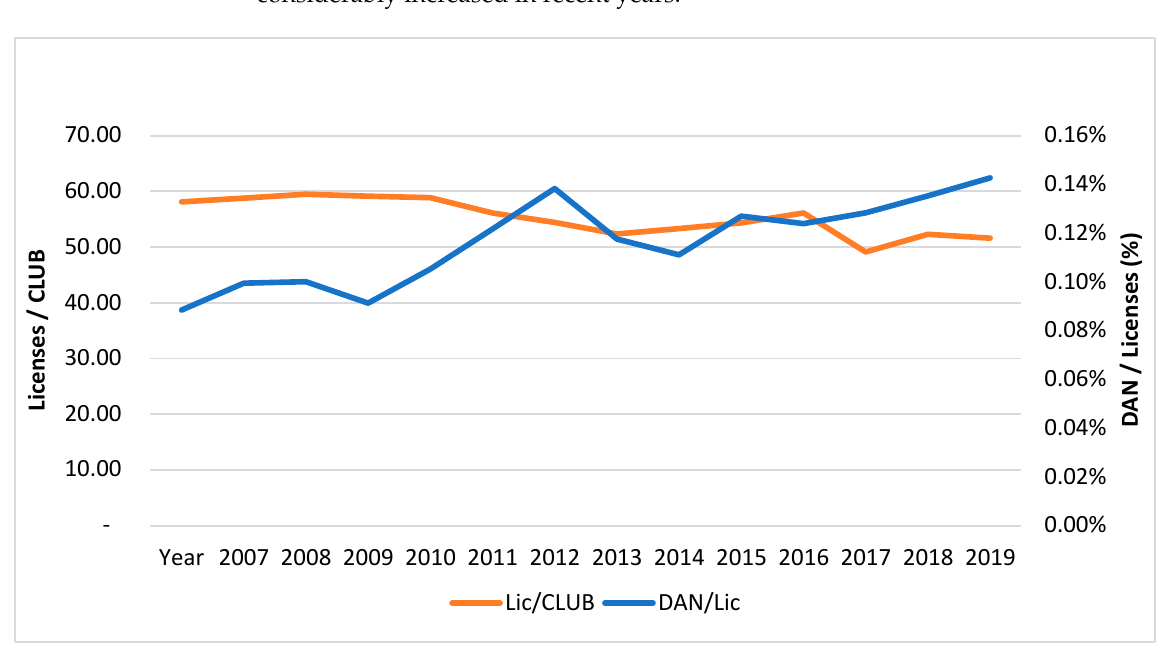
Figure 1. Demographic proportions of clubs, DAN and Licences over the period 2007–2020. Source: Own